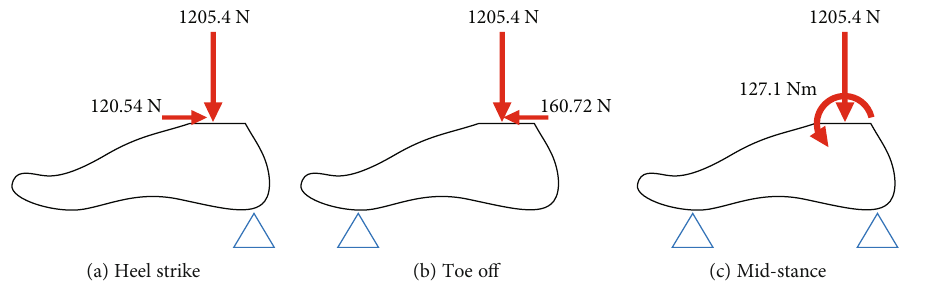
Figure 4: Boundary conditions for foot optimization.